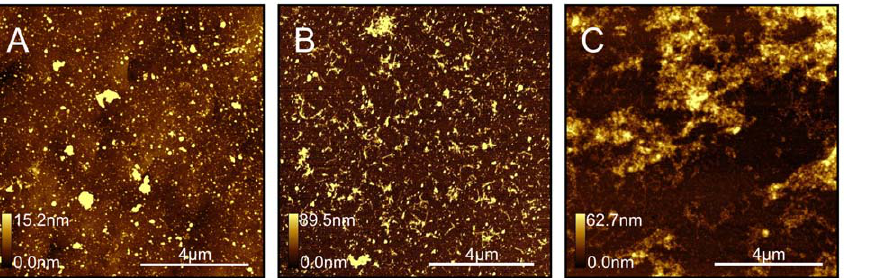
Figure 1. AFM topography images (10 6 10 m m) of amyloid fibril formation on NH 2 - modified surfaces: (A) after 10 minutes, (B) after 6 hours, and (C) after 22 hours incubation at 37 6 C in HEPES buffer, pH 7.8.